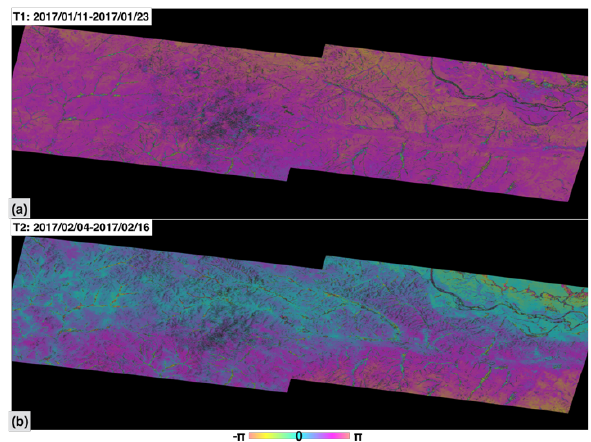
Figure 2. Sentinel-1 interferograms of high-latitude permafrost regions during time series InSAR processing